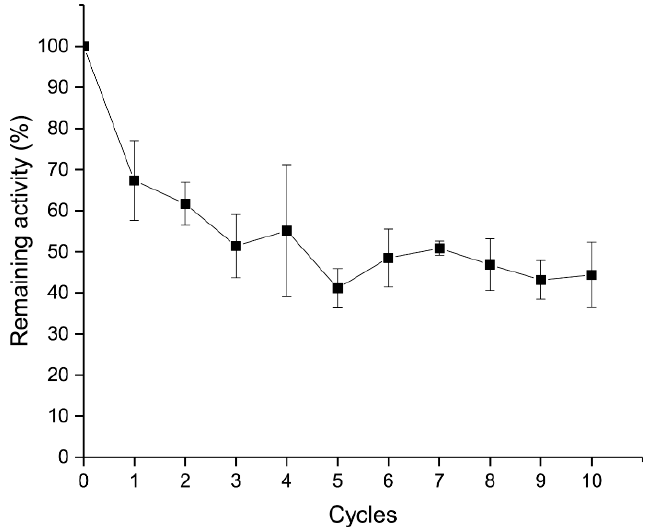
Figure 7. Operational stability of R483A-LrInu CLEAs.